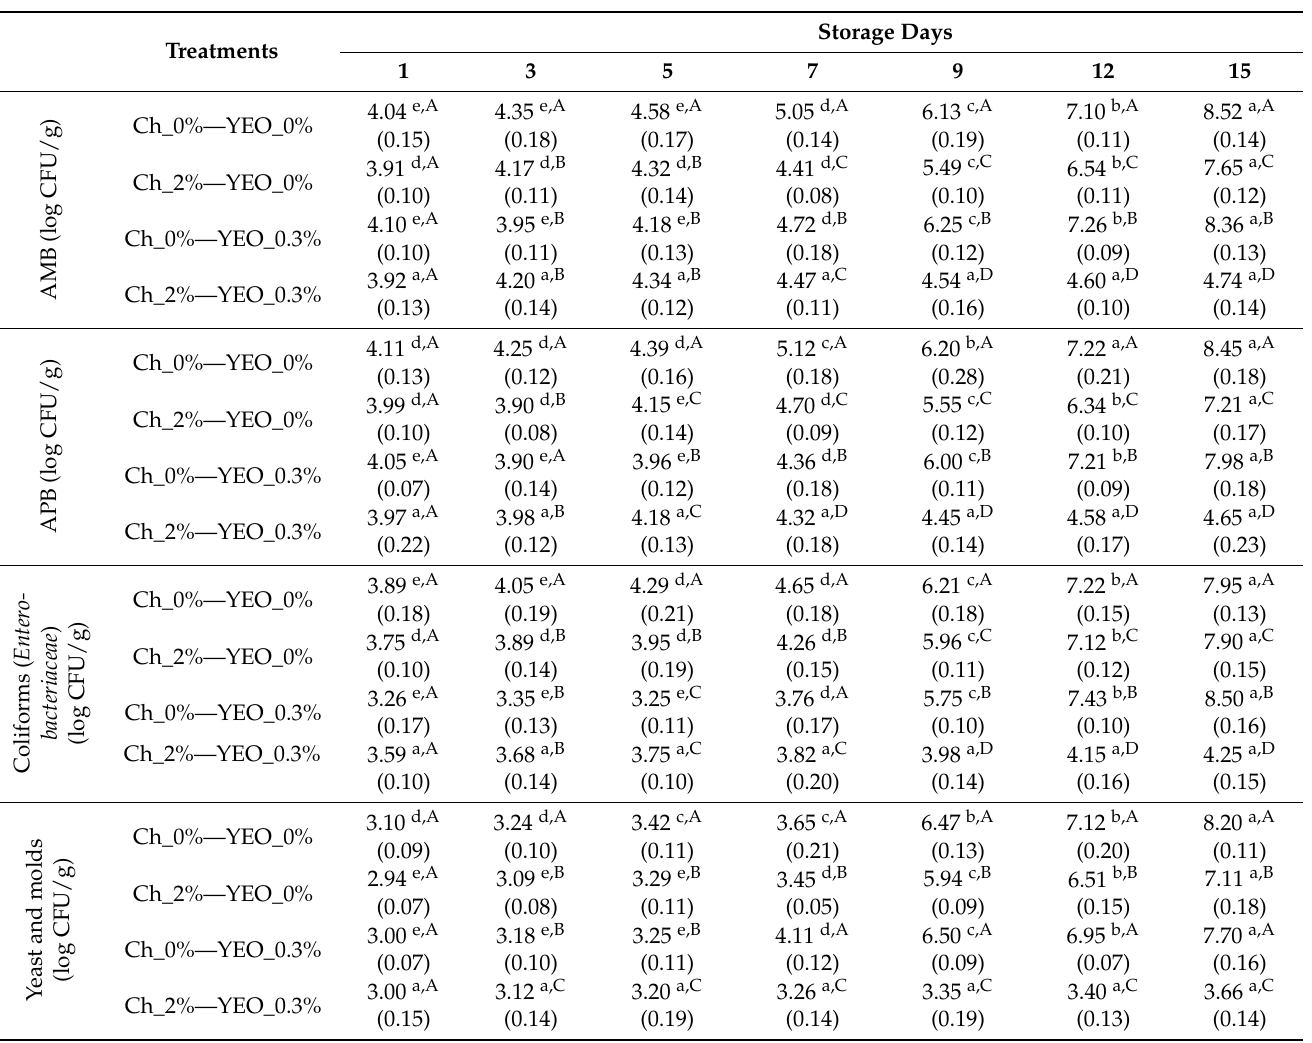
Table 4. Effect of different types of coating and storage time on the population of total aerobic mesophilic bacteria (AMB), total aerobic psycrotrophic bacteria (APB), coliforms ( Enterobacteriaceae ), and yeasts and molds in chicken breast fillets stored at 4 ◦